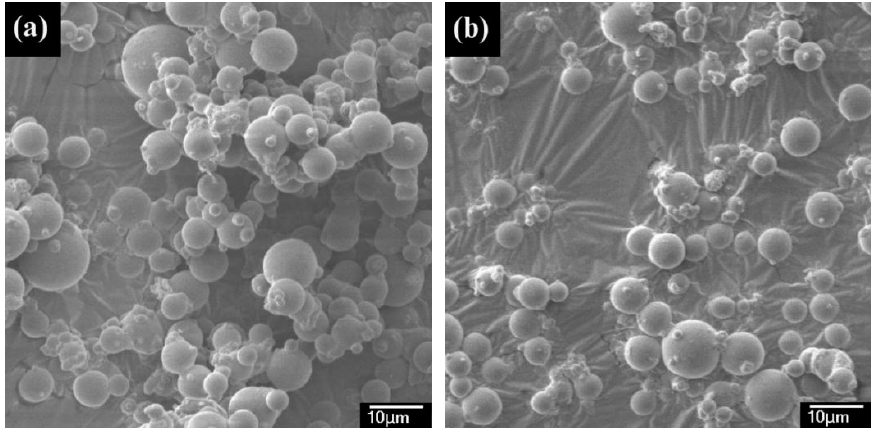
Figure 2. SEM images of (a) P(AA- co -NVF) and (b) P(AA- co -VAm) microgels.